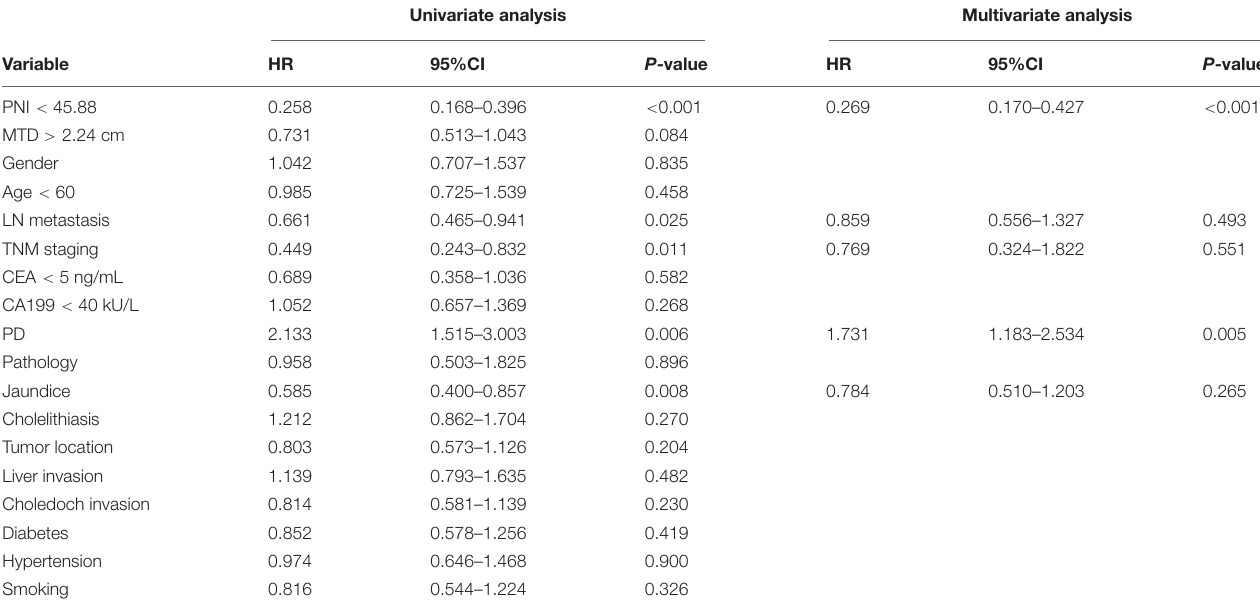
TABLE 4 | Univariable and multivariate regression analyses of factors for predicting overall 3-years survival of study patients. Univariate analysis Multivariate